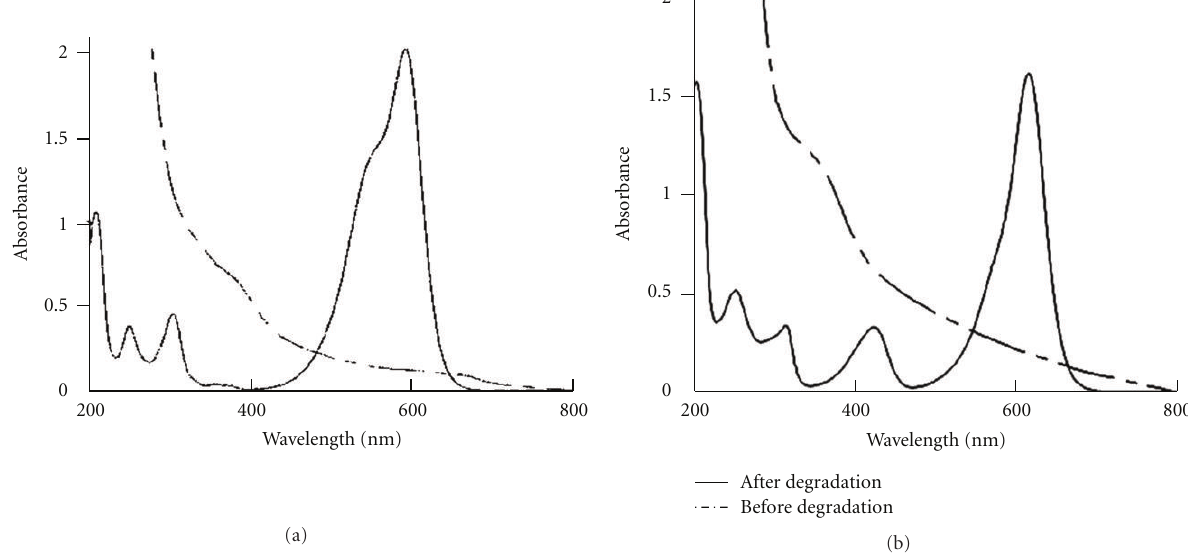
Figure 3: UV-visible spectra of crystal violet (a) and malachite green (b) at 0 h (control) and after 2h, decolorized by CM-4 in mineral salts medium water (pH 7.5). The experience was performed by a bacterial consortium CM-4 with dyes at concentrations (50mg/L) supplemented by yeast extract (0.1%) and glucose (7mM), at 35 ◦ C, under shaking conditions